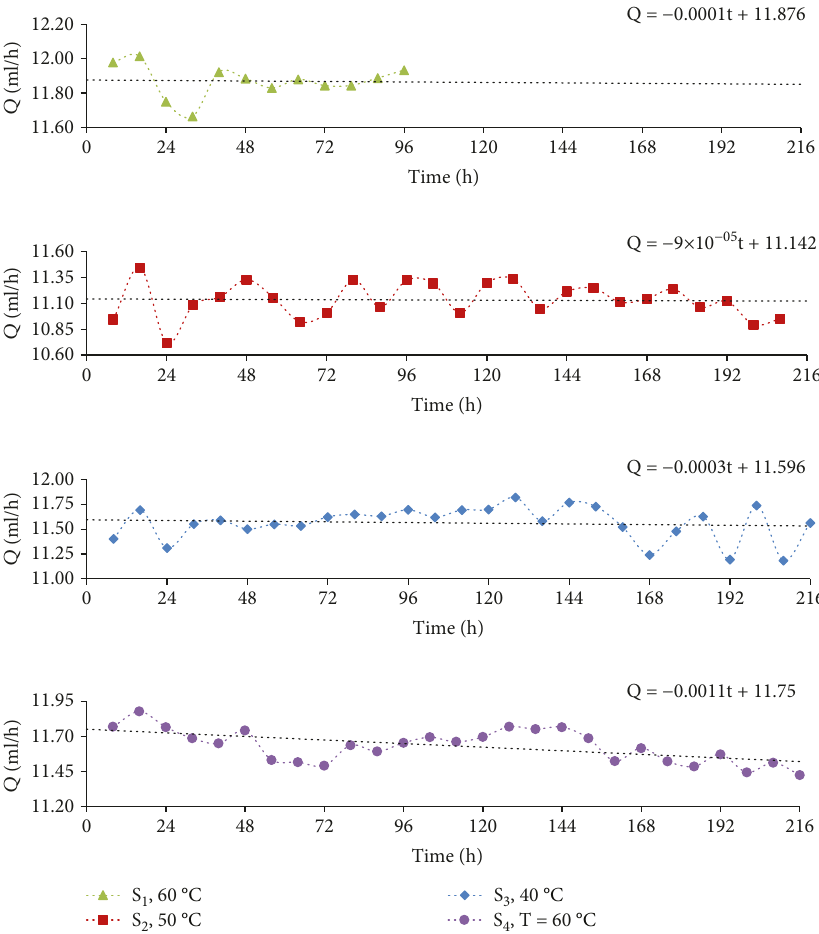
Figure 6: Variation process of the out fl ow